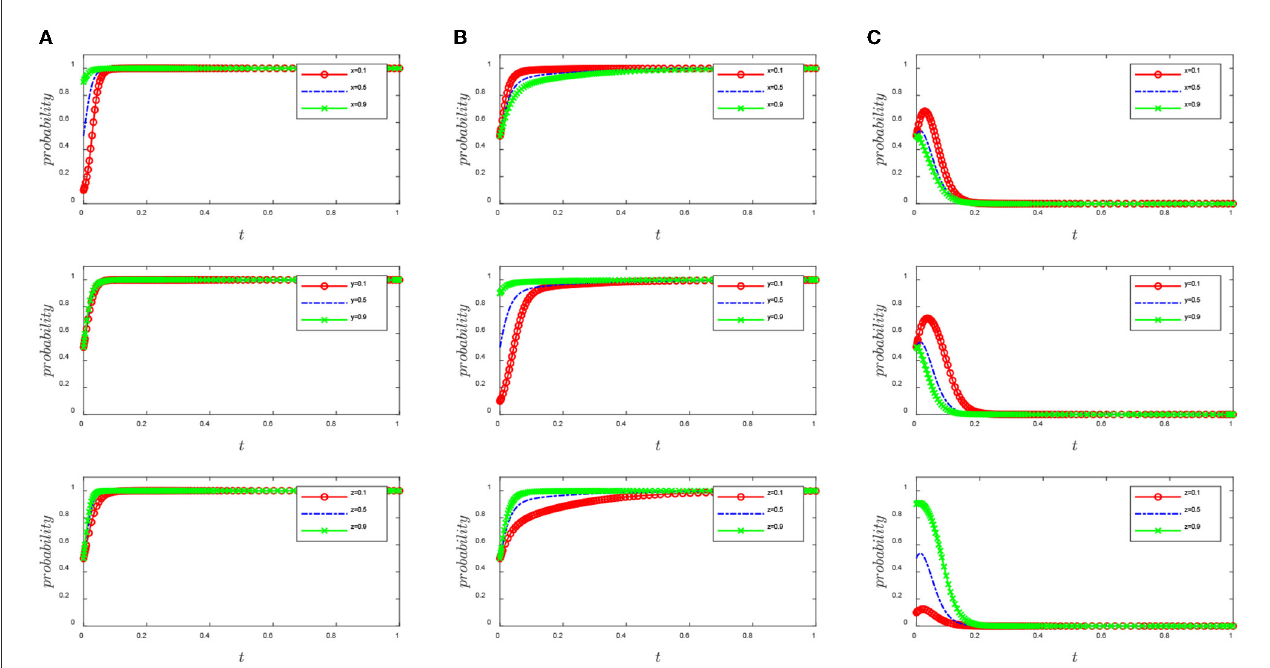
FIGURE7 Effect of different initial ratios on the evolution of the system. (A) Recycling industry, (B) urban management officer, and (C) government.